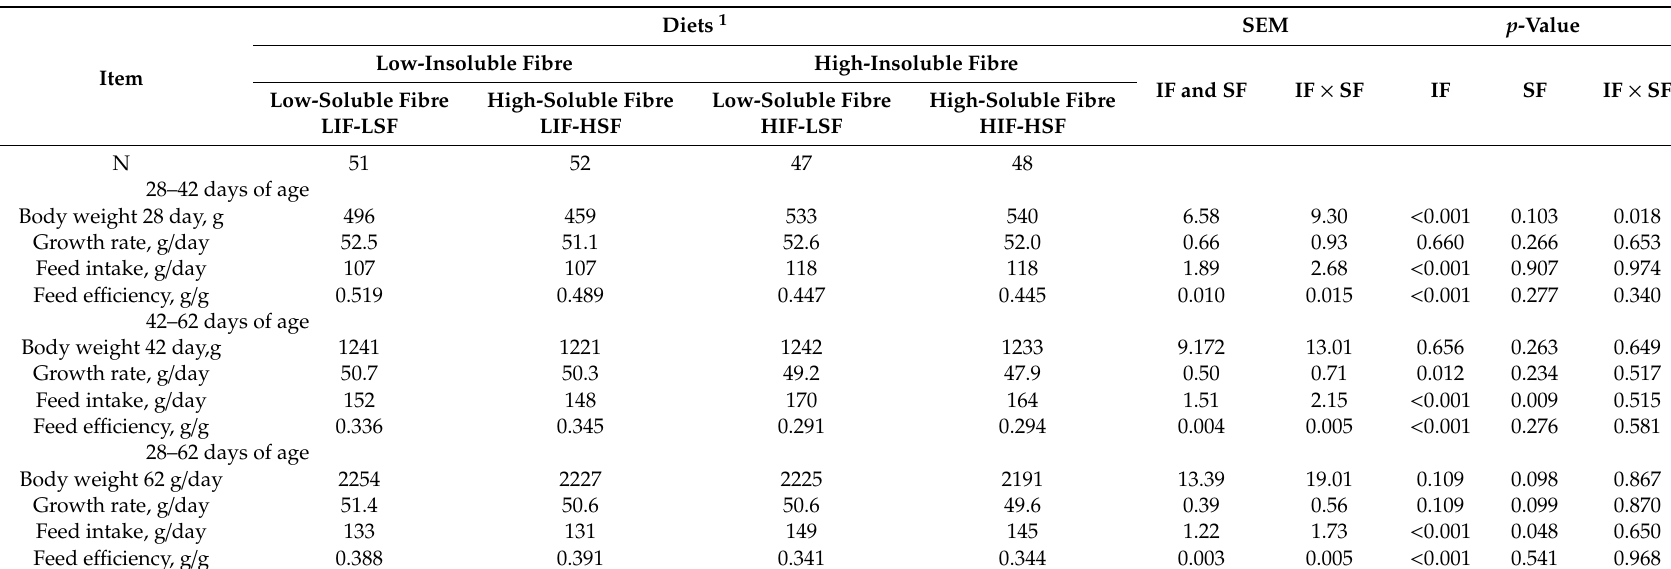
Table 2. E ff ect of dietary level of insoluble and soluble fibre on rabbits’ growth performance from 28 to 62 days of